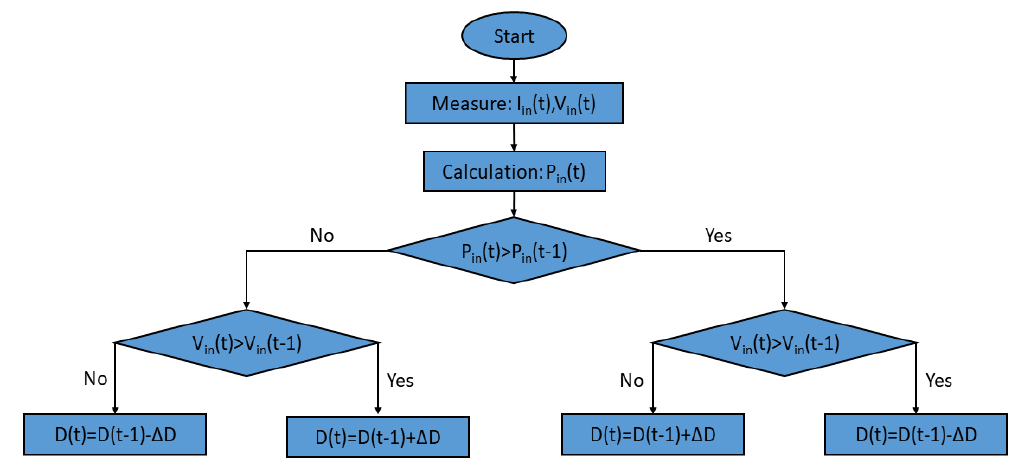
Figure 3. P&O algorithm diagram.